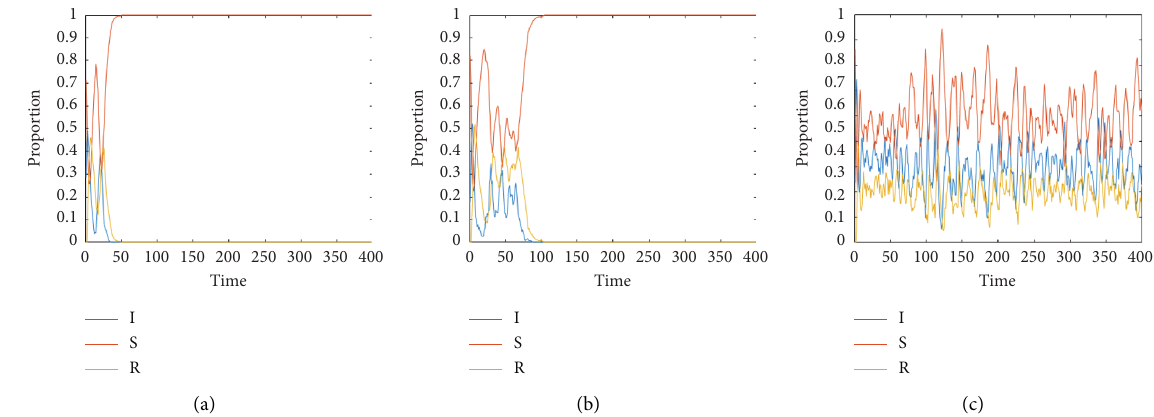
Figure 12: Transmission curve of epidemic model with immune recovery rate of 0.1, 0.3, and 0.5. (a) c � 0.1. (b) c � 0.3. (c) c � 0.5. 1 0.8